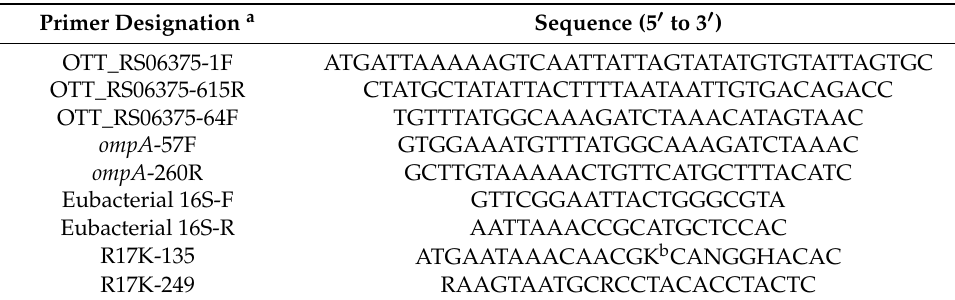
Table 2. Oligonucleotide primers used in this